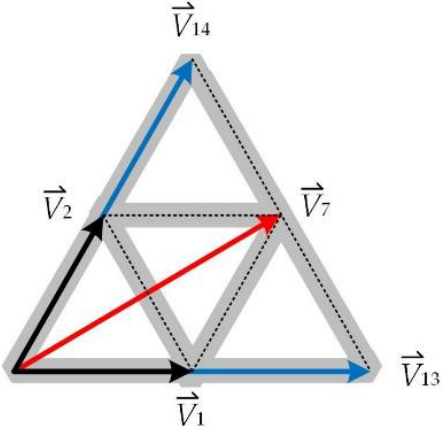
Figure 6. Boundary areas for the first sector.